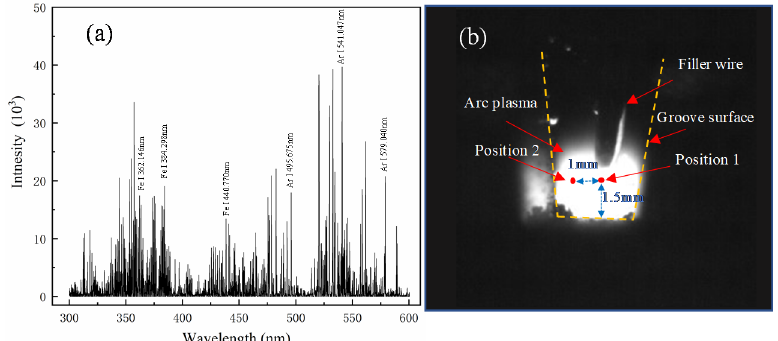
Figure 6. Spectrum of arc plasma in laser-MIG hybrid welding with magnetic field: ( a ) plasma spectrum and ( b ) spectral acquisition positions.